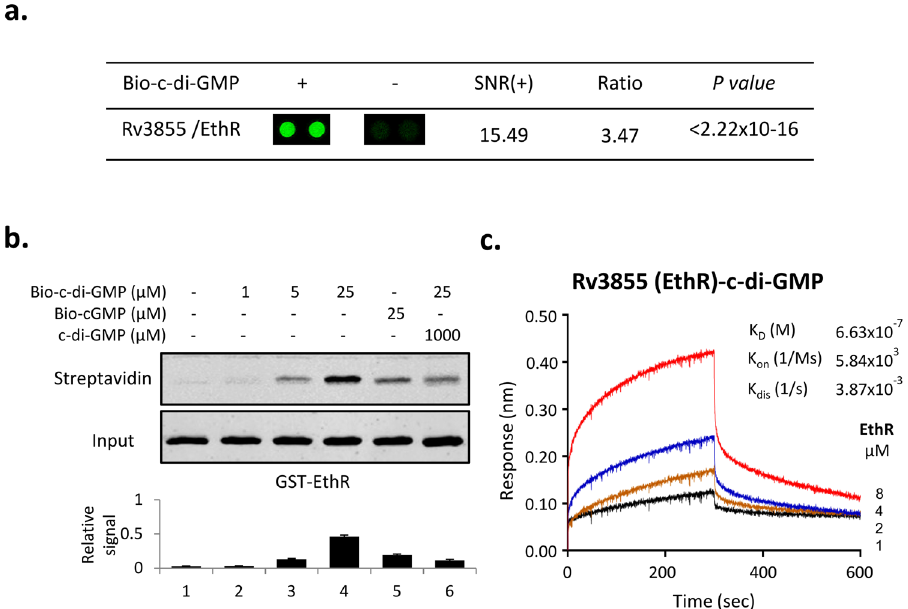
Figure 1. Characterization of the interaction between Ethr and c-di-GMP. ( a ). c-di-GMP binds protein Ethr on the protein microarray. Cy3 signal was measured at 532 nm by a fluorescence microarray scanner. + : in the presence of biotin-c-di-GMP; − : in the presence of biotin alone. ( b ). UV cross-linking assay for validation the interaction between Ethr and c-di-GMP. Purified GST tag Ethr was co-incubated with 1, 5, 25 μ M